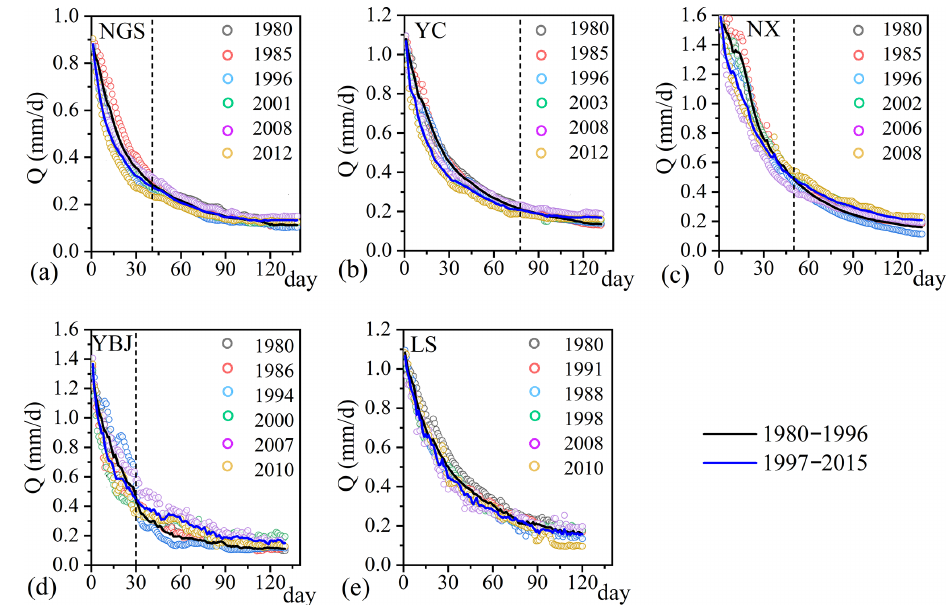
Figure 4. Discharge recession for selected years with approximately the same initial discharge Q 0 in each subbasin.